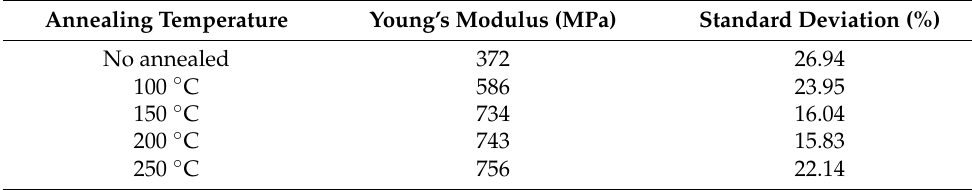
Figure 4. Measured microscopic Young’s moduli of pristine and thermally annealed Nafion ® 211 membranes using AFM. Table 1. Average value and standard deviation of Young’s modulus measurement data for each membrane.